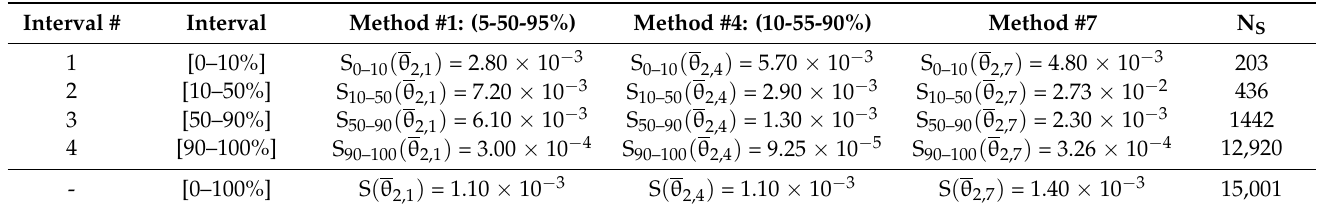
Table 20. Comparison between methods #1, #4, and #7 in terms of time-domain model performance indexes for different intervals of the process reaction curve for both identified models. The time- domain performance index for the whole response is also included in this table. N S represents the number of points for each interval.